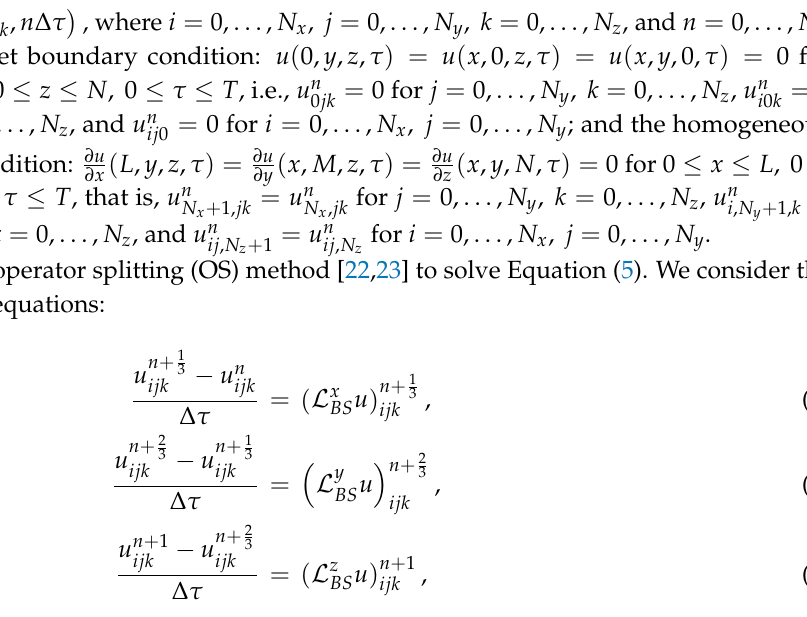
Figure 1. 3D non-uniform